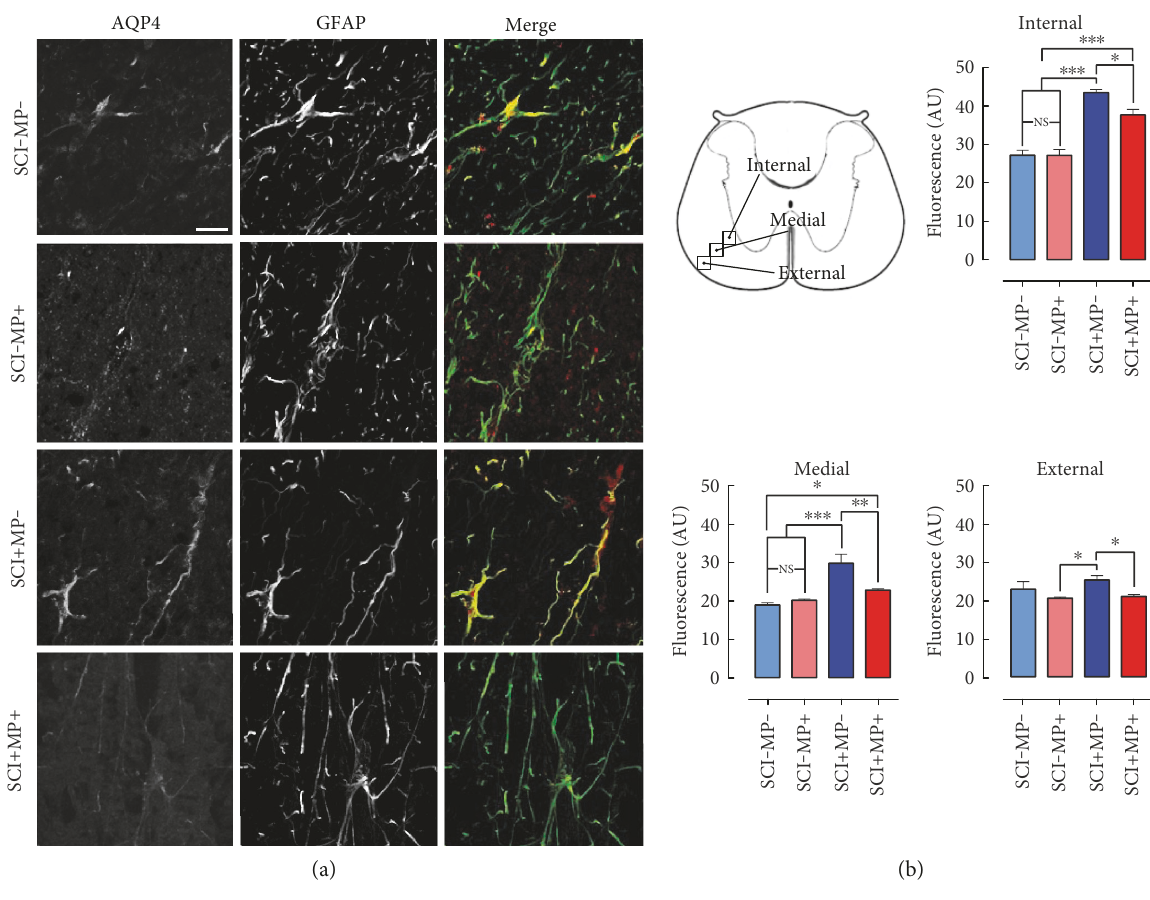
Figure 4: Systemic administration of MP reduces the increased expression of AQP4 in the spinal glia limitans after SCI. (a) Representative micrographs of the white matter glia limitans in the medial zone — indicated in (b) — of spinal cord sections immunostained for AQP4 (red) and GFAP (green) ( n = 5 per group). Merged signal of AQP4 expressed in astrocytes is depicted in yellow. Bar equals to 20 μ m. (b) Quanti fi cation of AQP4 immuno fl uorescent signal in 3 arbitrarily de fi ned regions of the white matter as indicated in the top panel diagram. Values are the mean ± SEM of 4 di ff erent photos per region per rat. ∗ p < 0 05 ; ∗∗ p < 0 01 ; ∗∗∗ p < 0 001